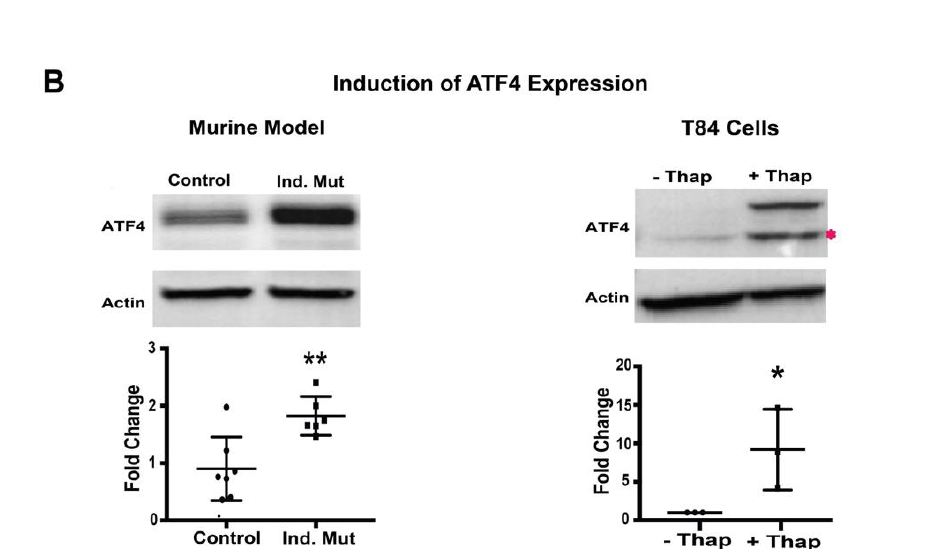
Figure 3. Protein kinase RNA-like endoplasmic reticulum kinase (PERK)-mediated pathway: ( A ) Western blot image and quantification of P-eIF2α, and eIF2α with respect to actin in Control/inducible (Ind.) Mutant adult murine intestinal tissue lysate (left panel) and T84 cells with (+)/without (−) thapsigargin (Thap) treatment (right panel). ( B ) Western blot images and quantification of ATF4 with respect to actin in adult murine intestinal tissue lysate (left panel) and T84 cells with (+)/without (−) thapsigargin (Thap) treatment (right panel). *, p < 0.05, **, p < 0.01 by student t-test.